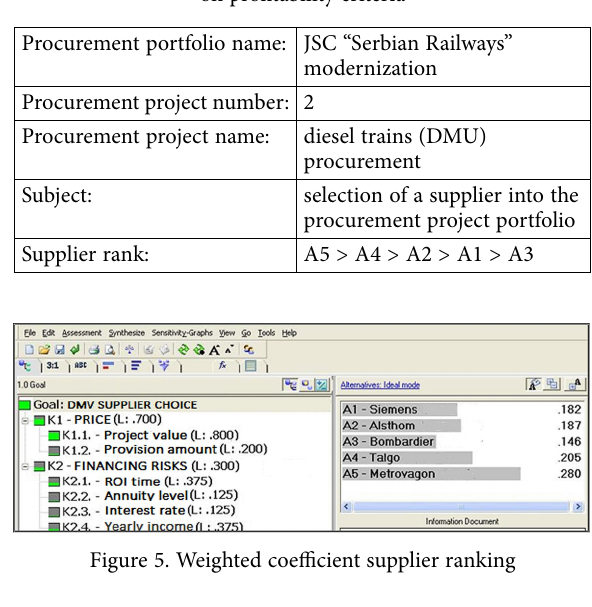
Table 10. DMU supplier ranking results based